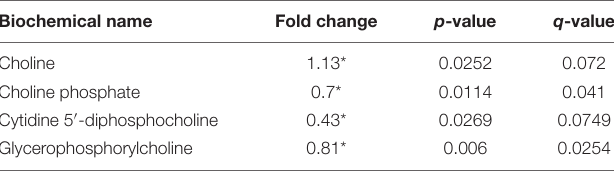
TABLE 5 | Choline-derived metabolites are altered in LPS placenta.